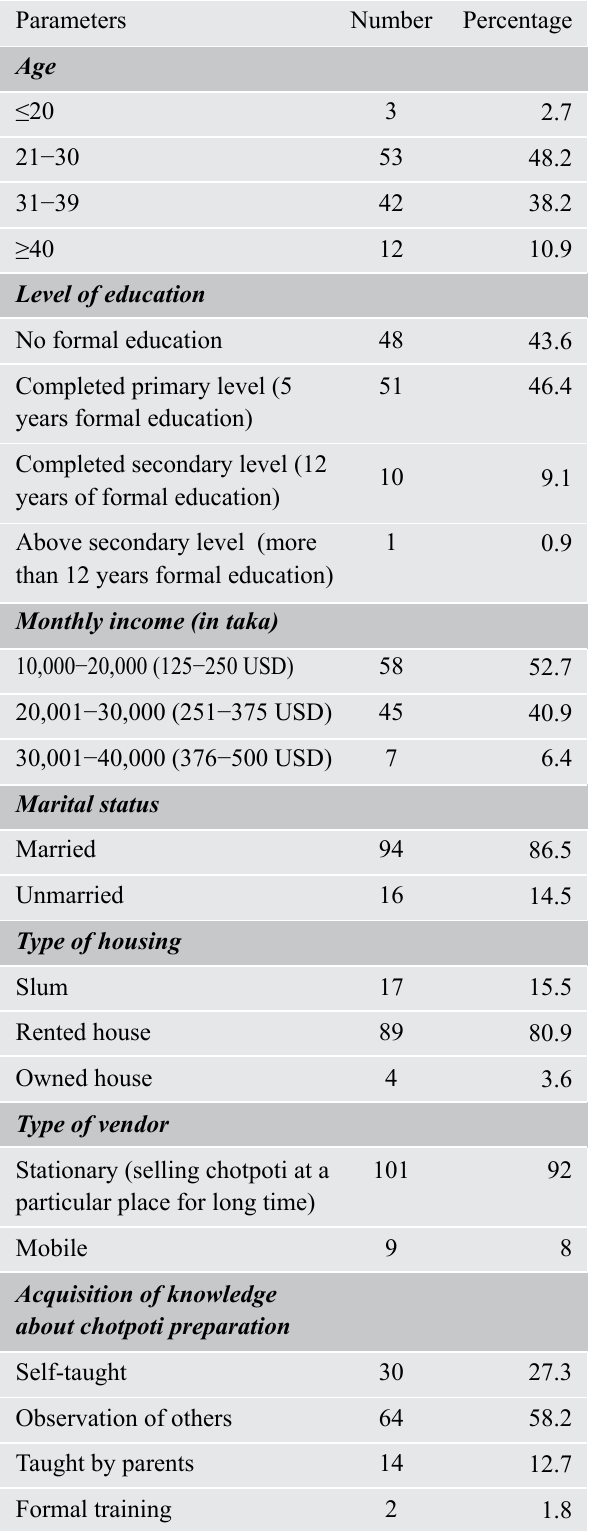
Table I: Socio-economic and demographic profile